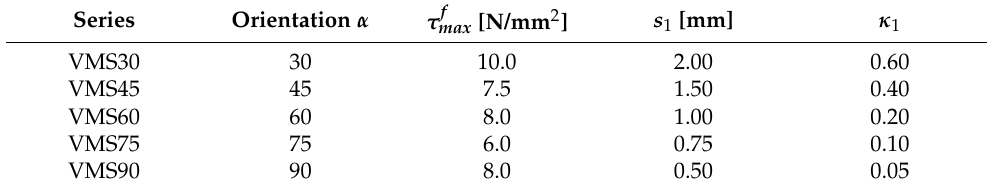
Table 3. Parameters for analytical bond stress-slip relationship.